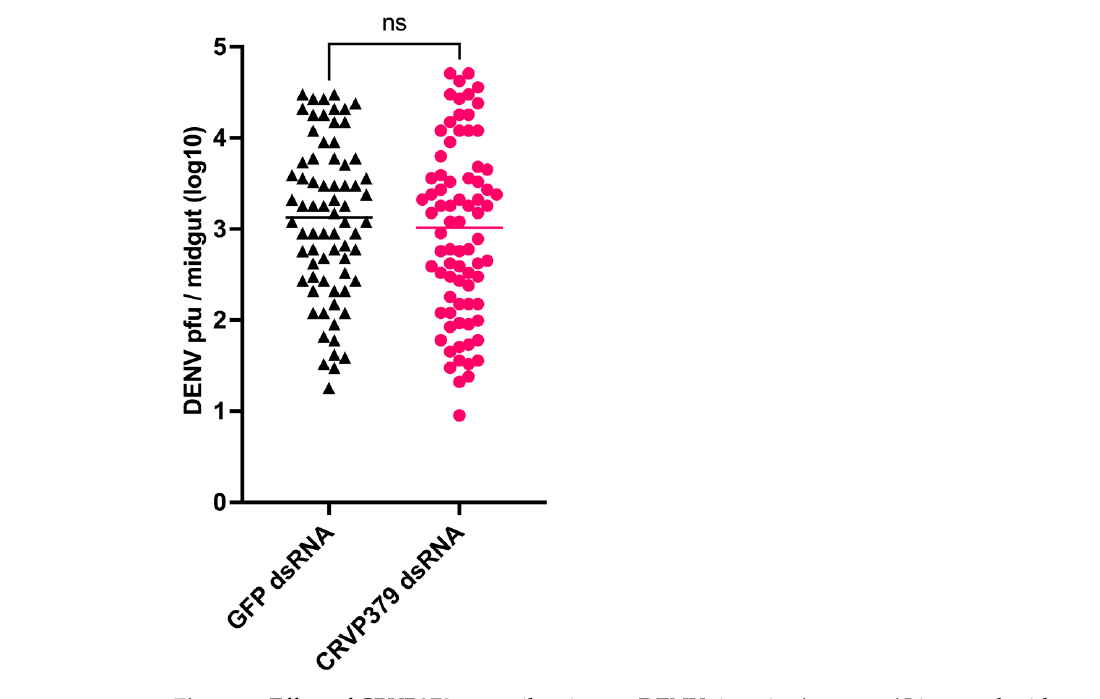
Figure 3. Effect of CRVP379 gene silencing on DENV titers in Ae. aegypti Liverpool midguts seven days after infection. Control mosquitoes injected with GFP dsRNA ( n = 72), CRVP379 dsRNA injected misquotes ( n = 78). ns—non-significant.